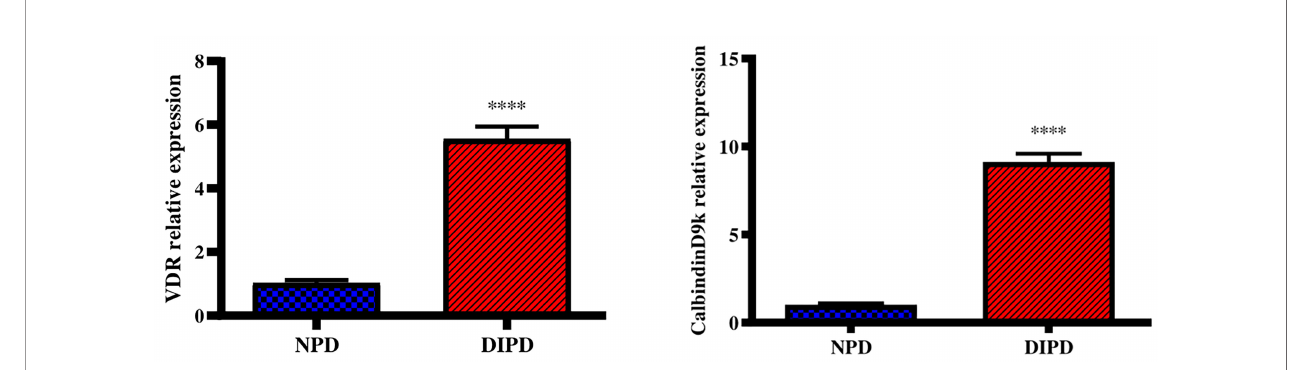
FIGURE 5 | Evaluation of intestinal calcium transport through intestinal VDR and calbindinD9k gene expression in the non-pre-diabetic (NPD) group and diet-induced pre-diabetic (DIPD) group (n=6, per group).Values are presented as mean ± SEM. ****= p < 0.0001 by comparison to